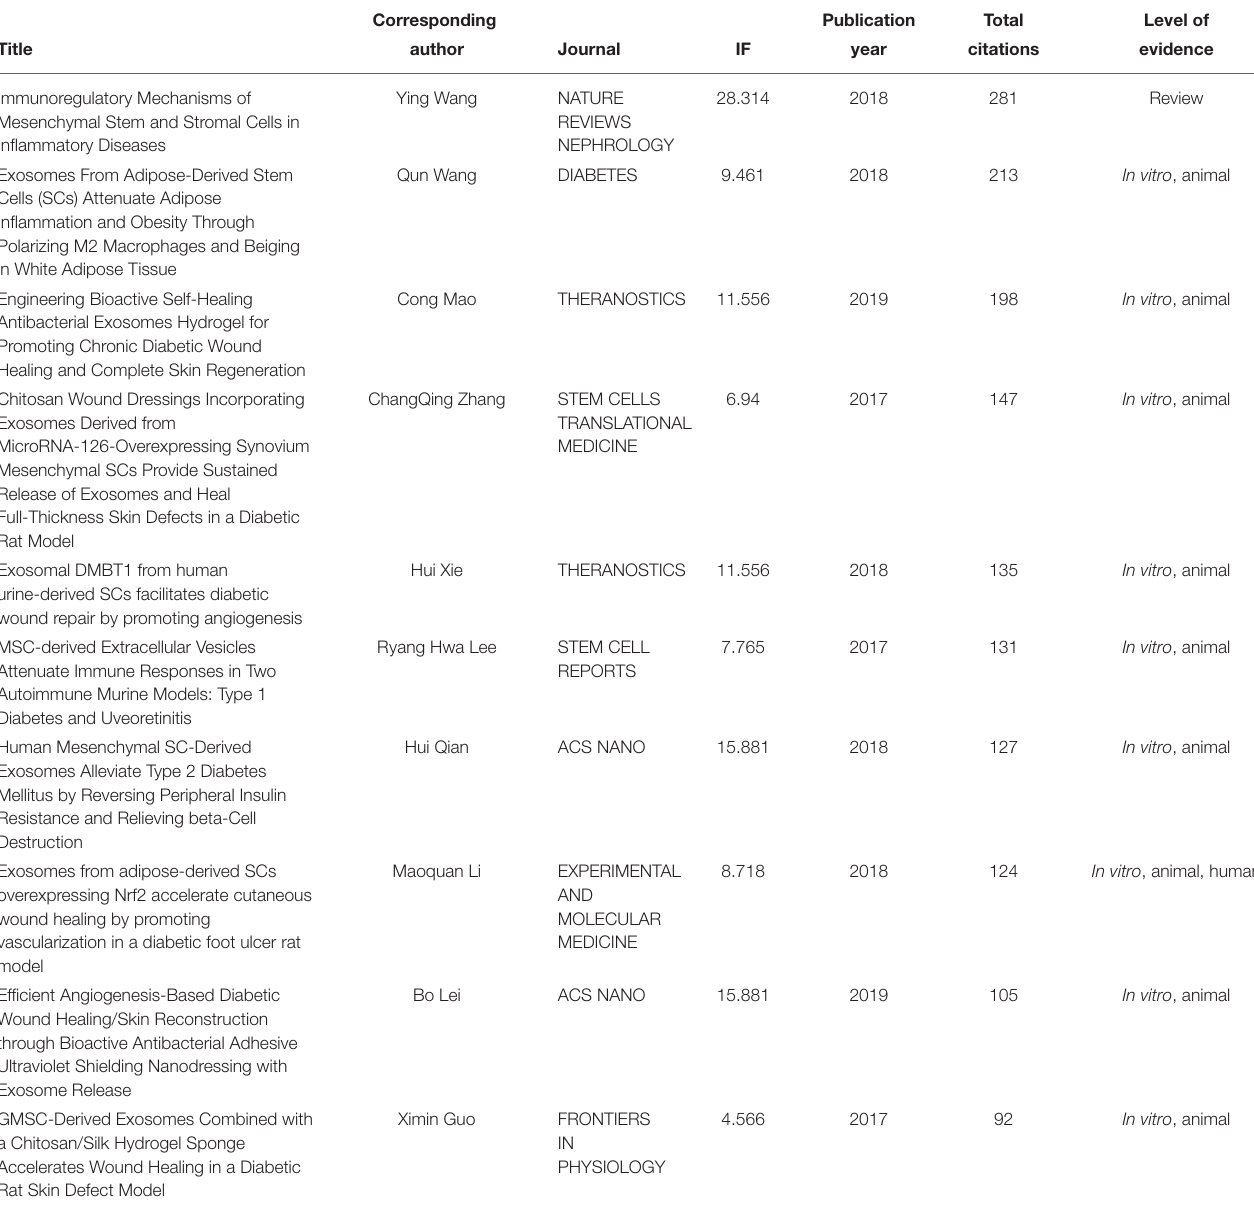
TABLE 5 | The top 10 references with the most citations in the field of SC-EVs for diabetes.